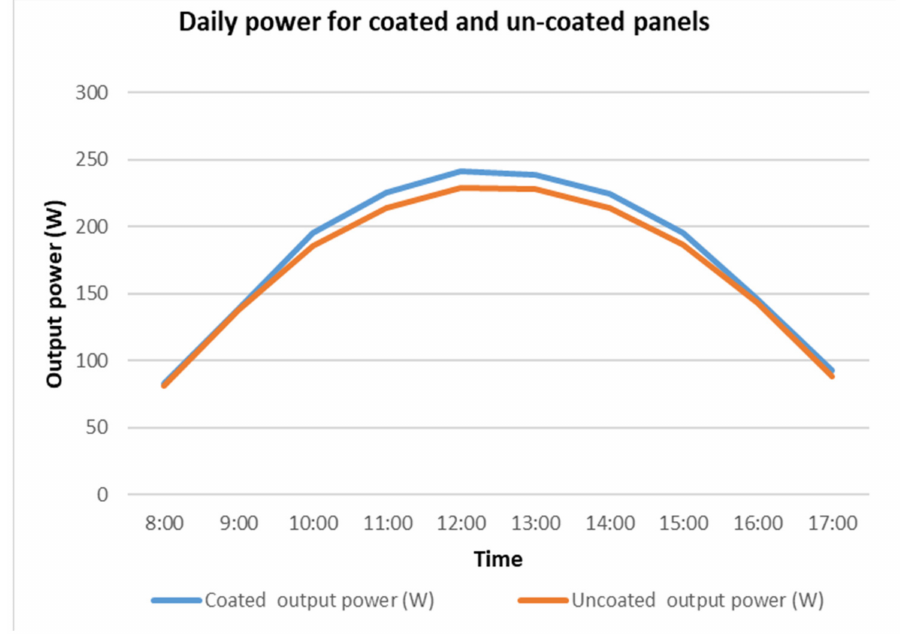
Figure 12. Hourly daily power for coated and uncoated